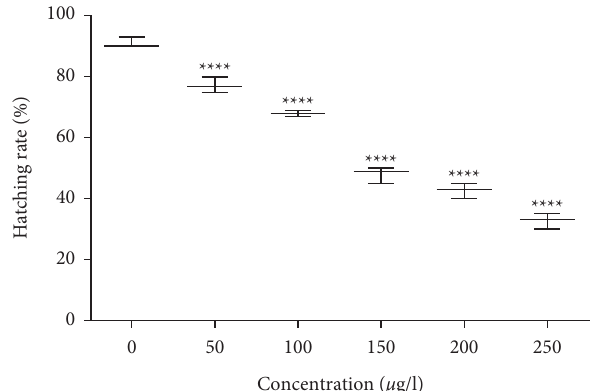
Figure 11: Hatching rate of the zebrafish embryos treated with TiO